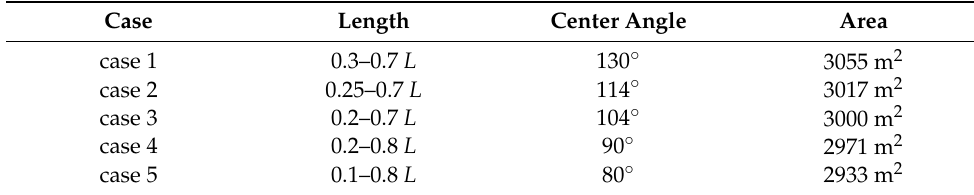
Table 3. Solar array layout with different cases.